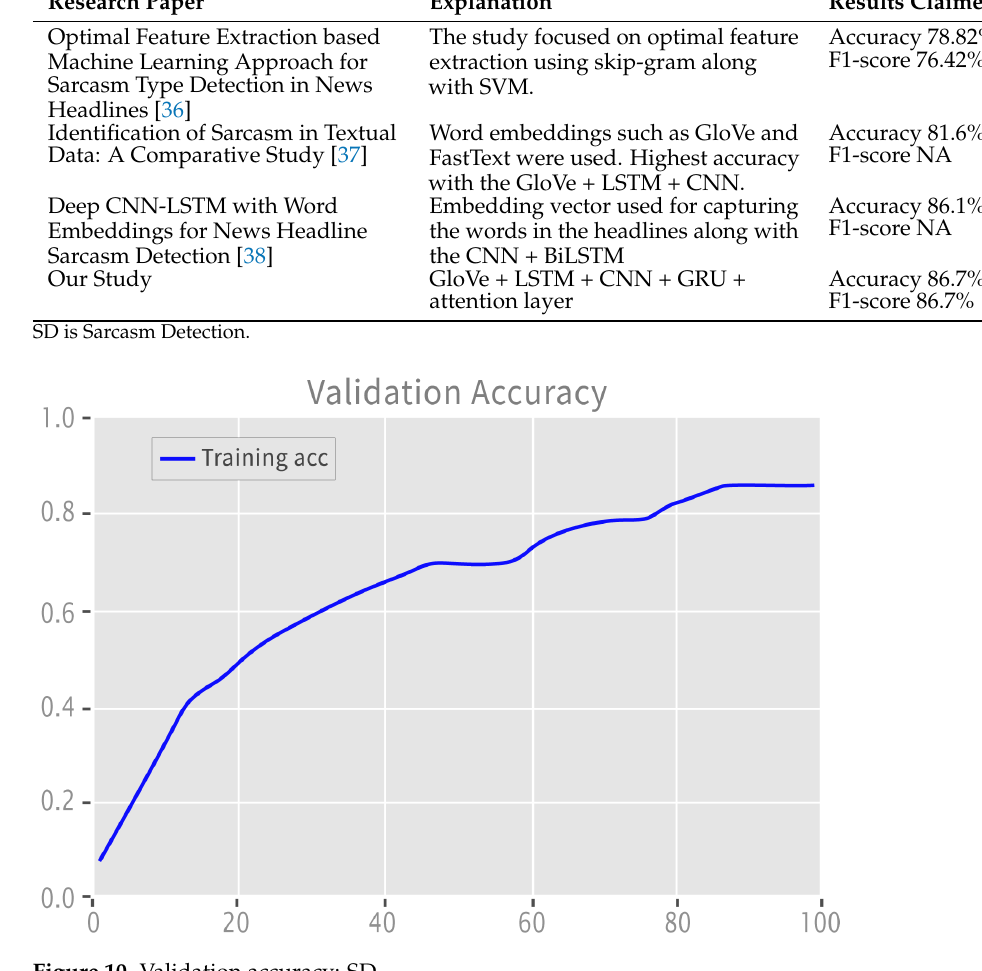
Figure 10. Validation accuracy: